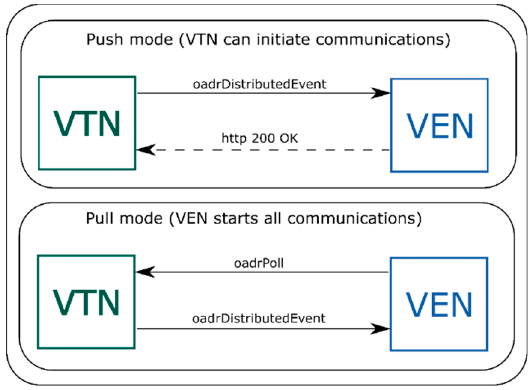
Figure 3. PUSH and PULL modes in OpenADR protocol.